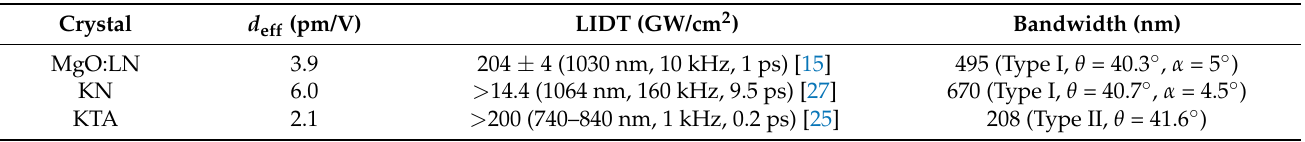
Table 1. Relevant optical properties of MgO:LN, KN and KTA for high power parametric amplification. The bandwidth shown is calculated for a L = 2 mm